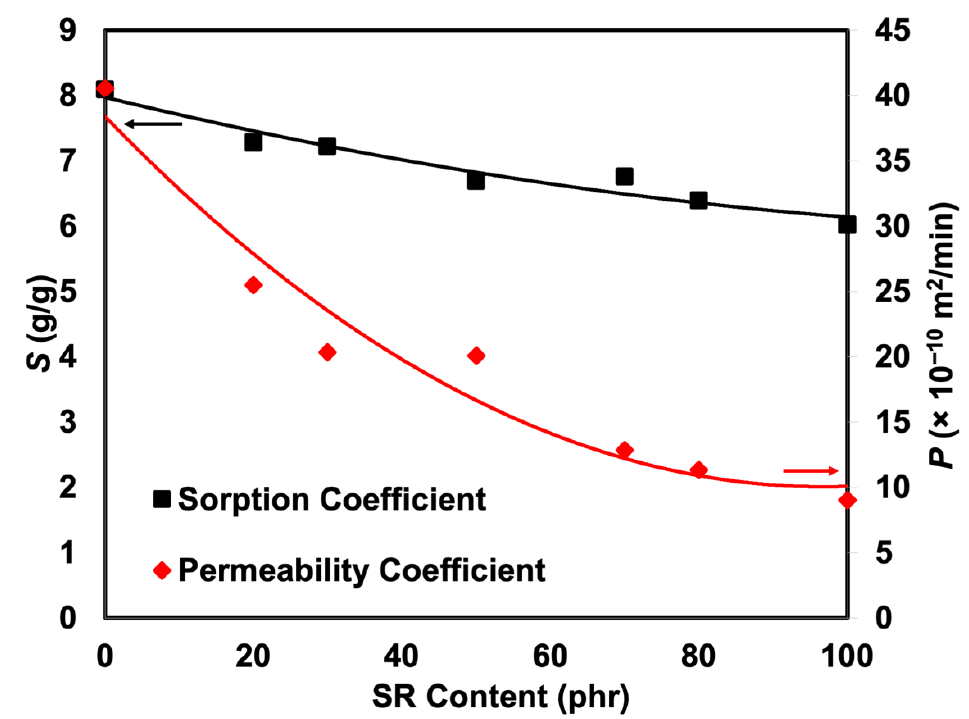
Figure 10. Sorption and permeability coefficients of SR/NR blends.